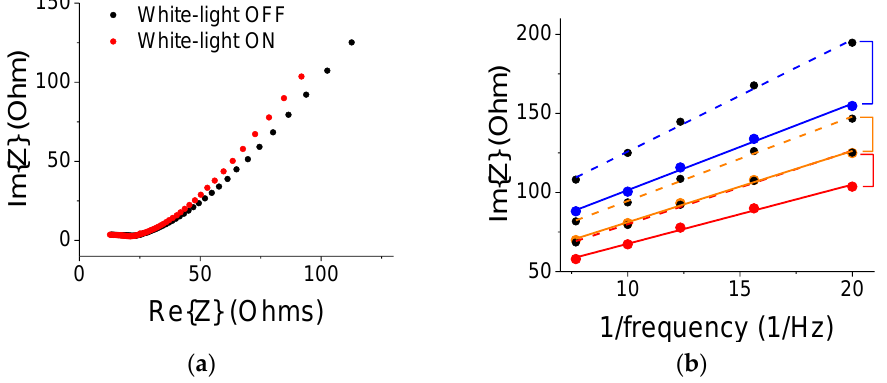
Figure 9. Results using EIS with a 300 W light source. ( a ) A typical EIS curve for 2 μ m TiO 2 particles with no filter. There is no light-induced change in the electrode resistance at Re{Z}~25 Ohms. ( b ) Analysis of the data from 5 mHz (20 1/Hz) up to 140 mHz (7.25 1/Hz) revealed a linear dependence on the inverse frequency and the lingering effect of prolonged illumination as measured in light OFF conditions. The colored dashed curves correspond to successive references (OFF states) for data taken with the blue, yellow, and no filter (red), respectively. The colored solid lines represent ON state data that were measured with blue, yellow, and no filter (red curve), respectively.